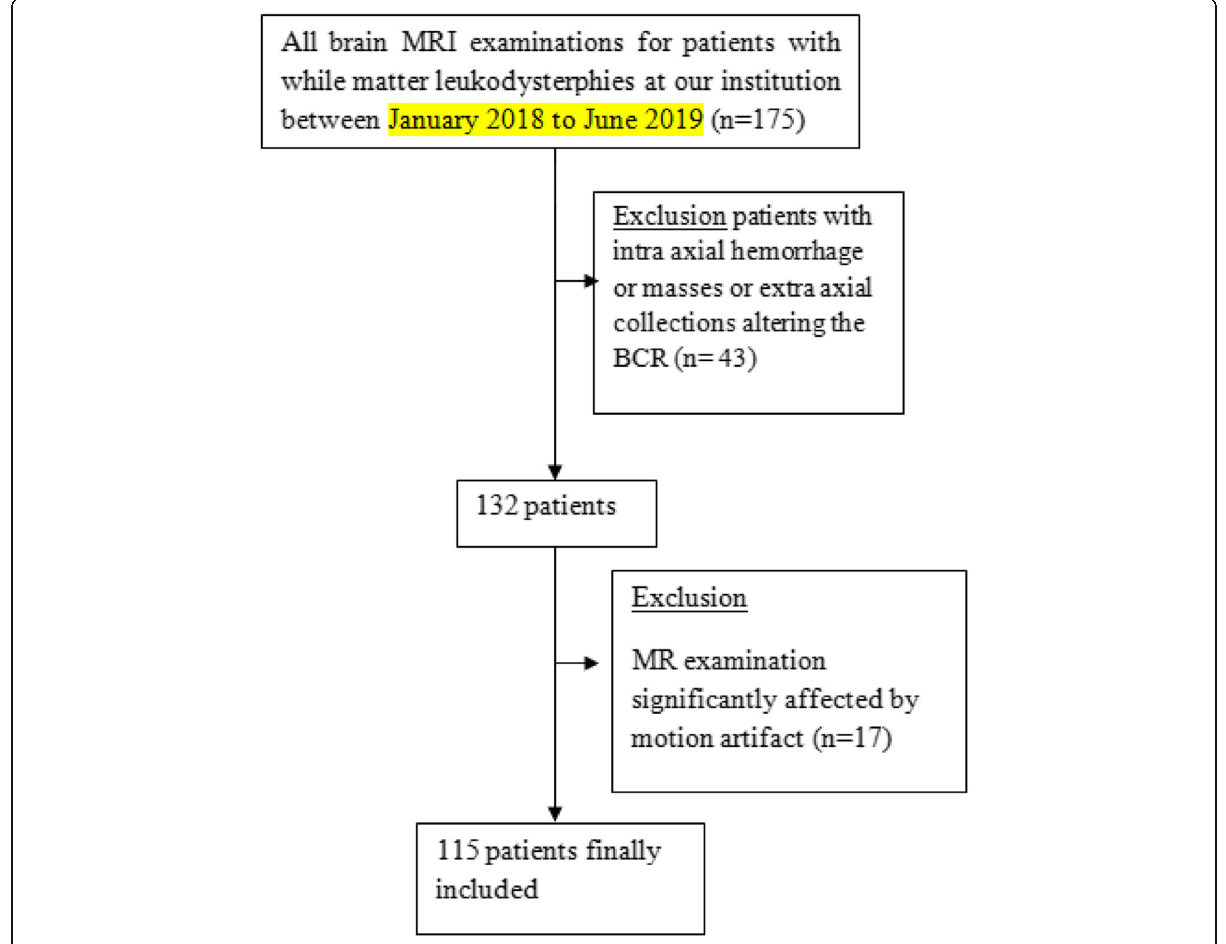
Fig. 1 Flow diagram showing the patient